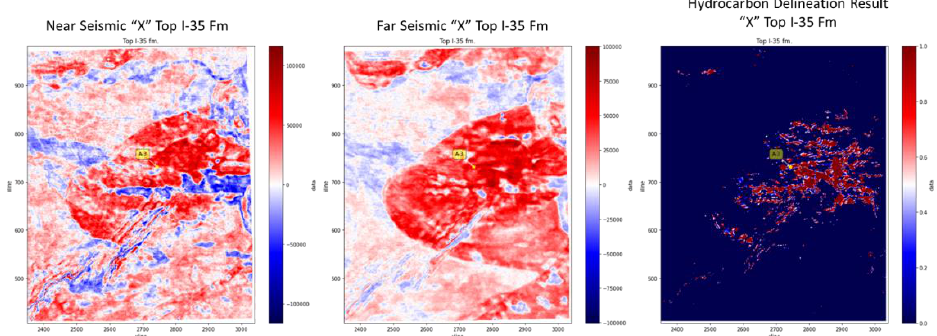
Figure 17. Hydrocarbon delineation result on Top I − 35 Formation.